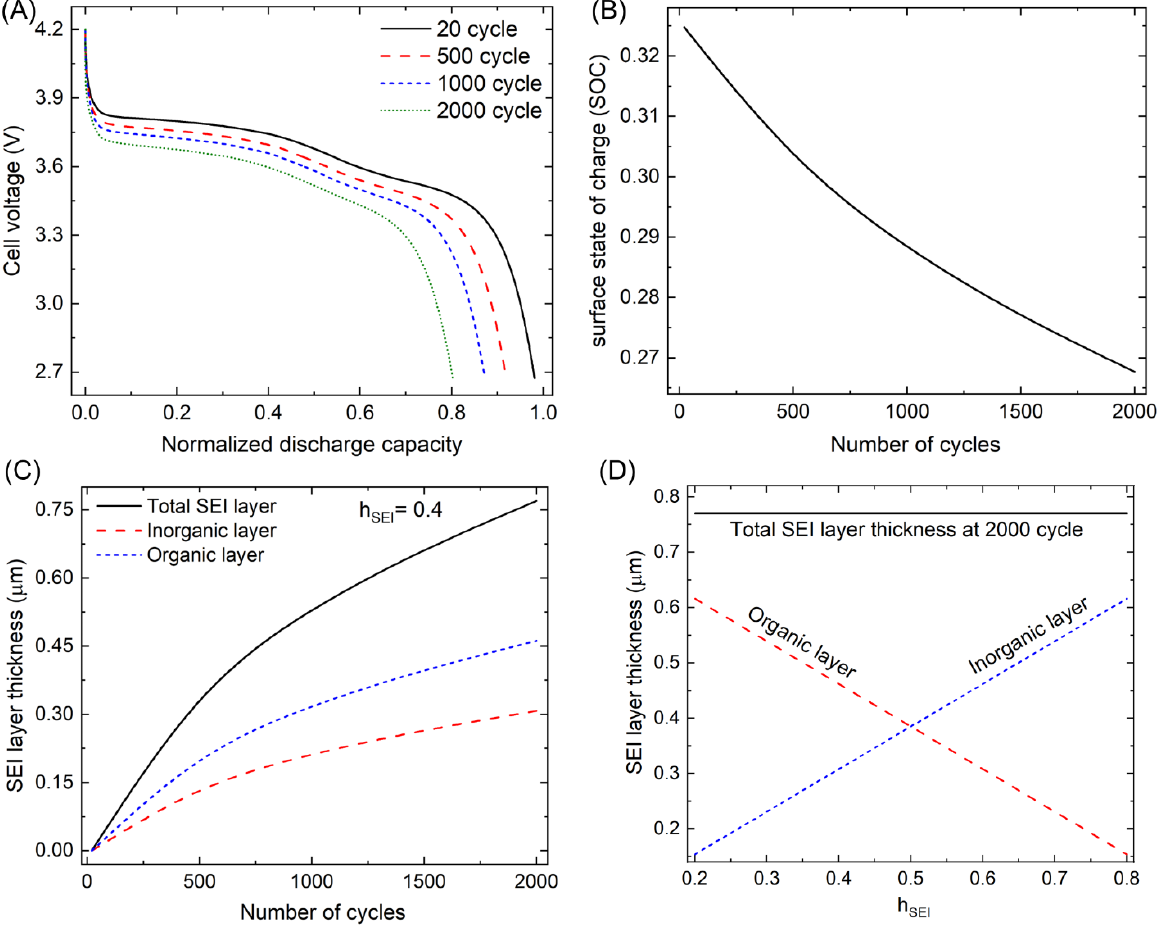
Figure 2. ( A ) Discharge curves over cycles. ( B ) Decrease in SOC of the negative electrode due to SEI formation. ( C ) Evolution of SEI layer thickness. ( D ) Thickness of the inorganic and organic SEI layer according to h SEI .